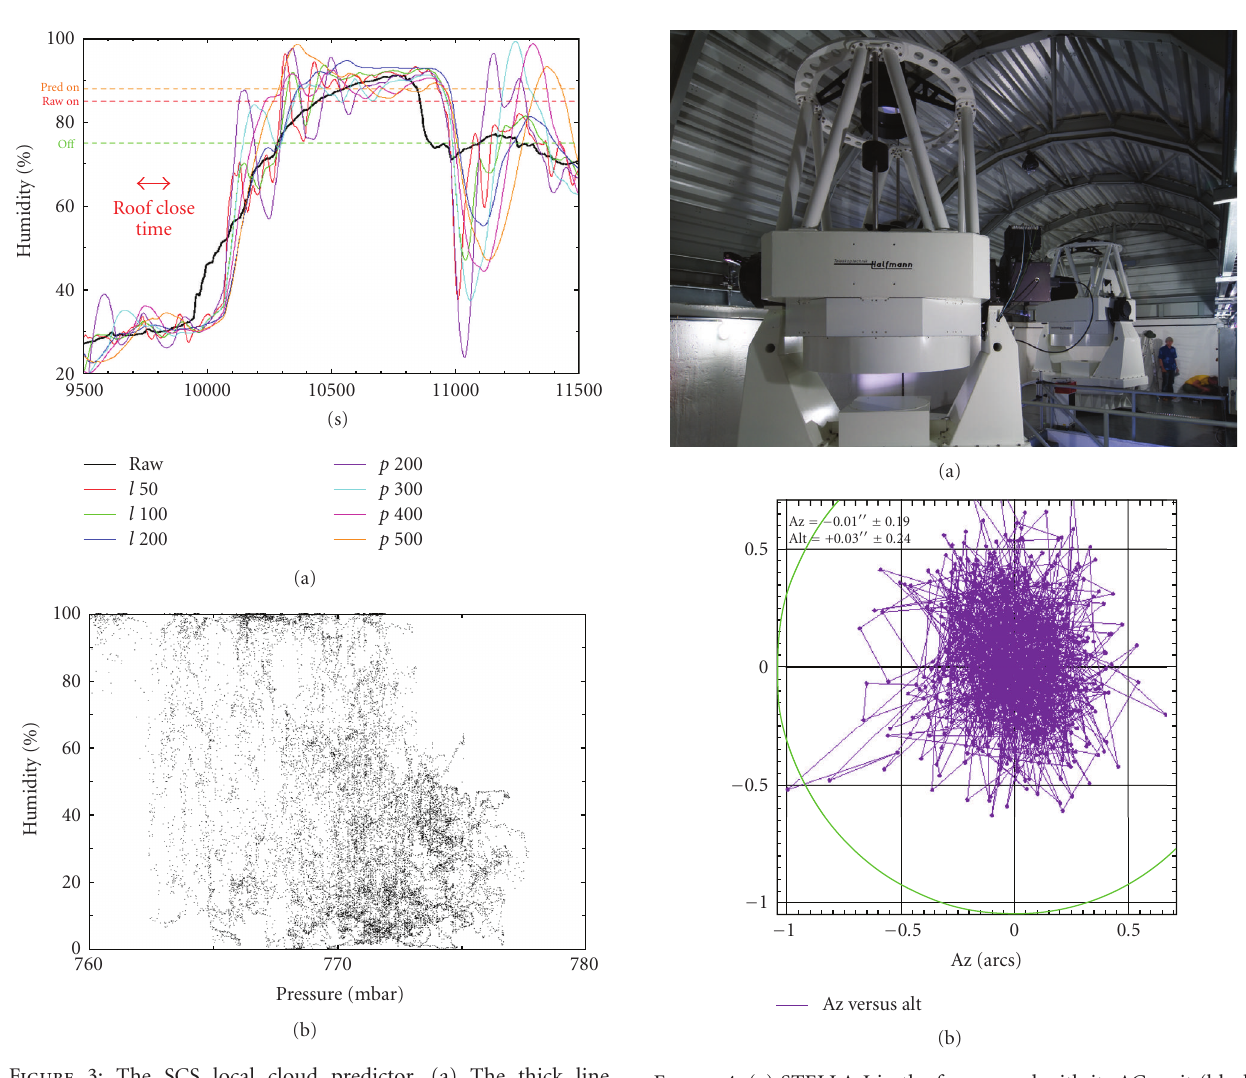
Figure 4: (a) STELLA-I in the foreground with its AG-unit (black box) in the right Nasmyth focus (with the fiber cable making a loop). STELLA-II is in the background. (b) Accumulated guiding corrections for a 1-hour exposure with the SES on STELLA-I. The dots are the individual alt-az pointings. The circle indicates the fiber entrance diaphragm of 120 μ m (2.5 arcsec). The guiding rms was 0.19 arcsec in azimuth and 0.24 arcsec in